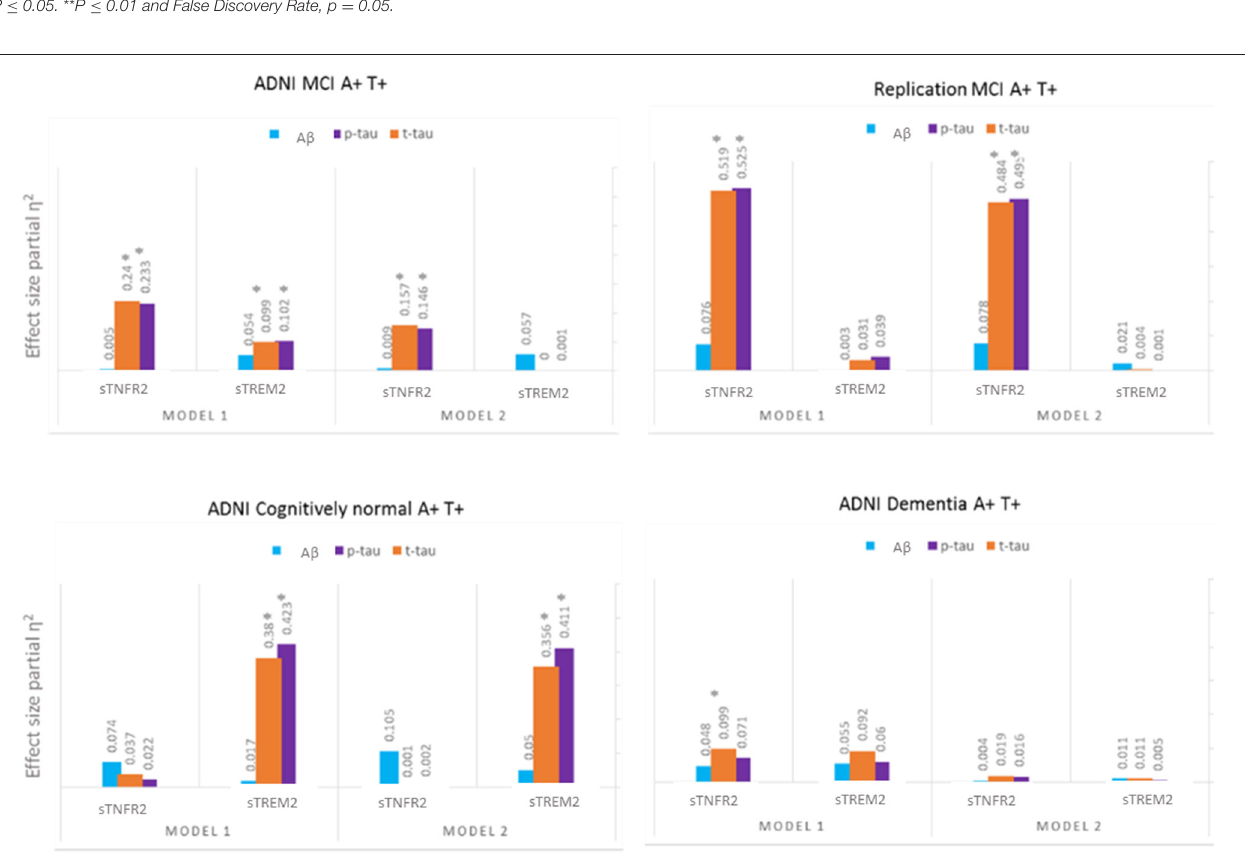
FIGURE 1 | Effect sizes for baseline CSF sTREM2 and sTNFR2 in linear models predicting baseline CSF t-tau, p-tau, and A β 42 in A + T + participants with MCI (ADNI cohort and replication memory clinic cohort) or AD dementia (ADNI cohort) and in A + T + cognitively normal participants. * P ≤